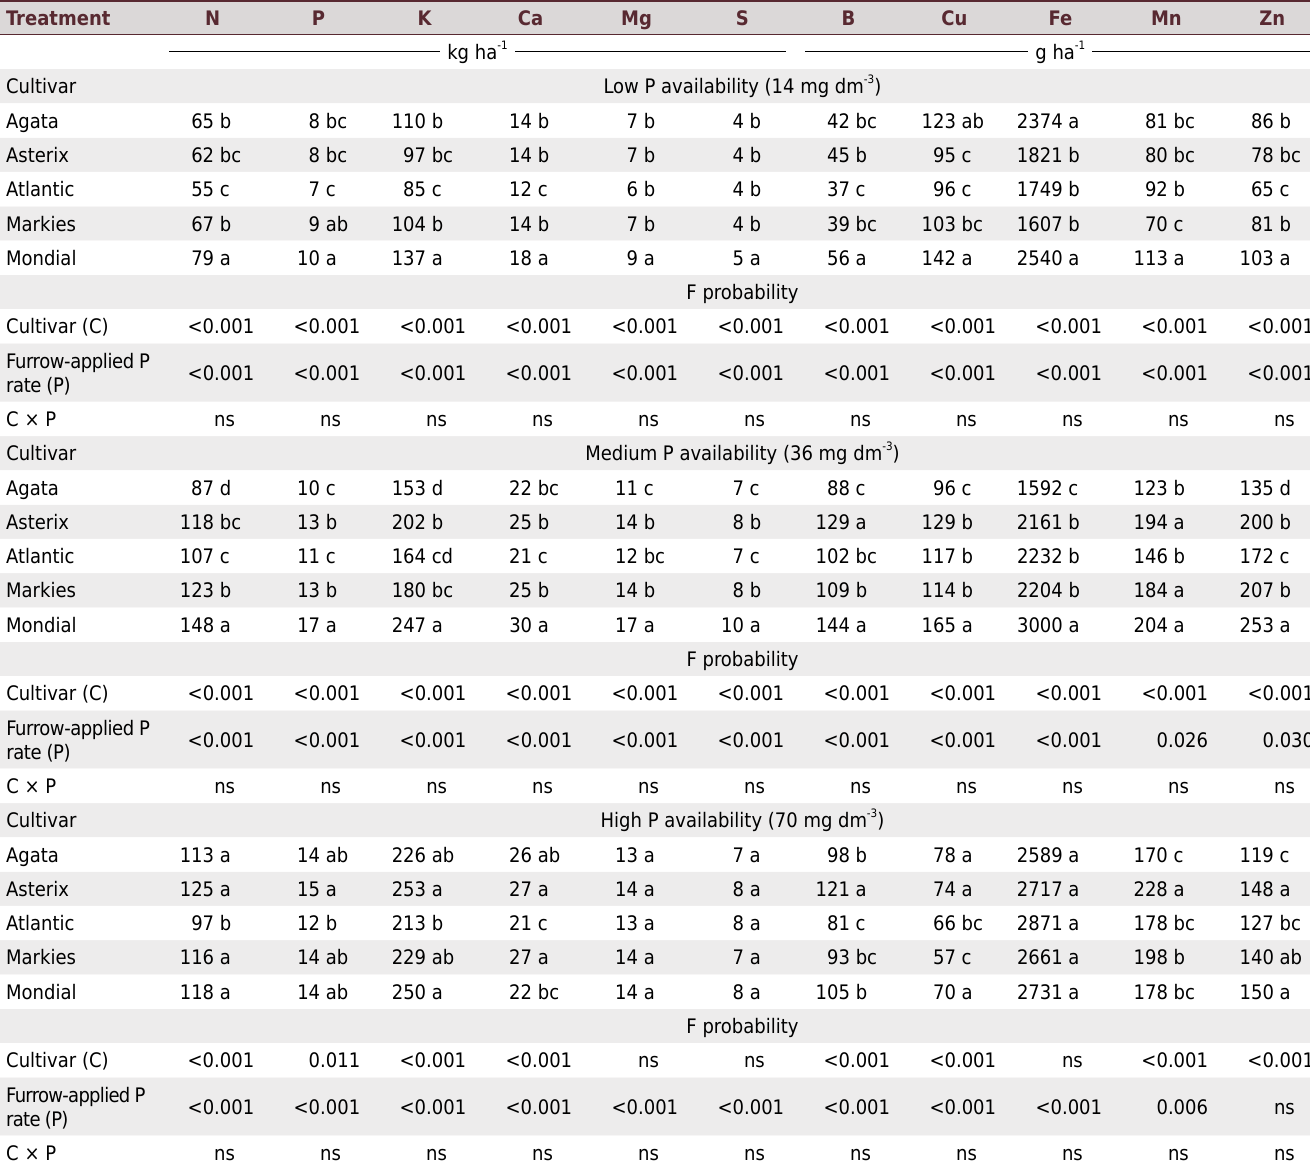
Table 3. Nutrient (N, P, K, Ca, Mg, S, B, Cu, Fe, Mn, and Zn) uptake by the potato cultivars as affected by rates of P applied in the planting furrow in soils with low, medium, and high P availability Treatment